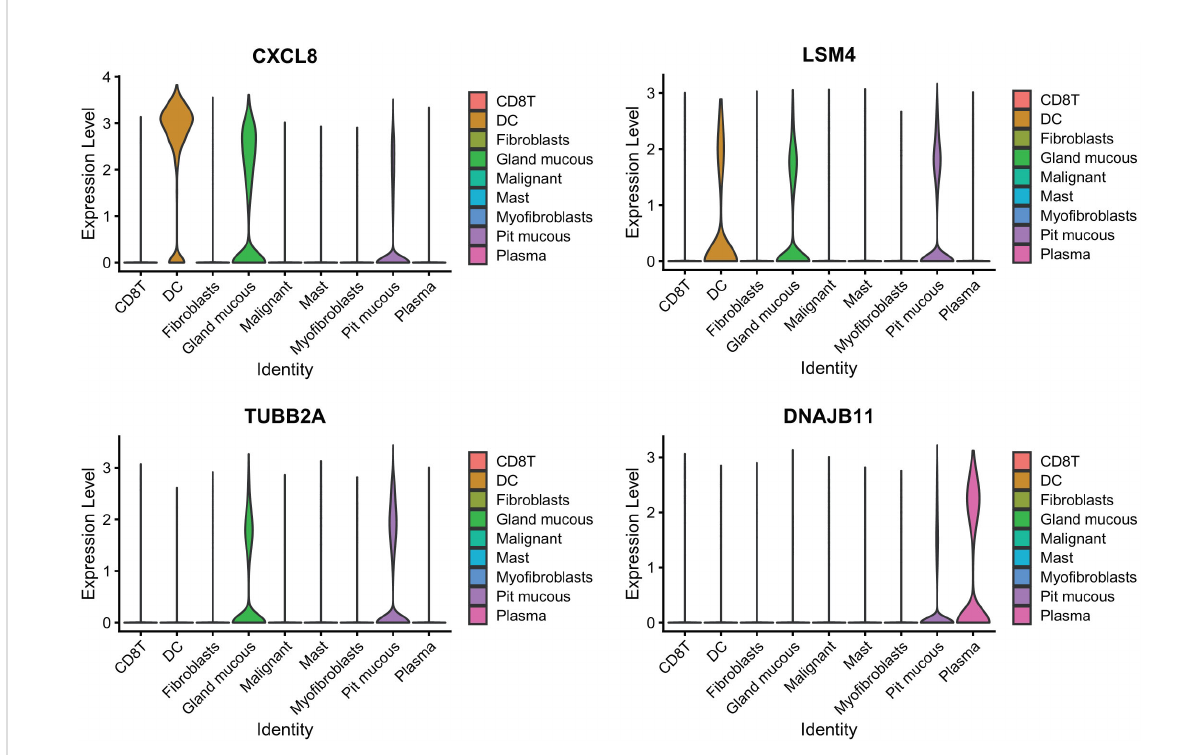
FIGURE 12 Expression of endoplasmic reticulum stress factors in different cell